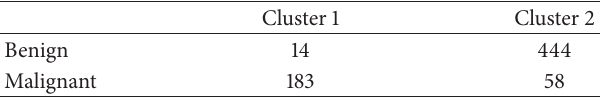
Table 7: Confusion matrix for the average clustering result with Hamming distance, for 𝑚 = 1.5 .